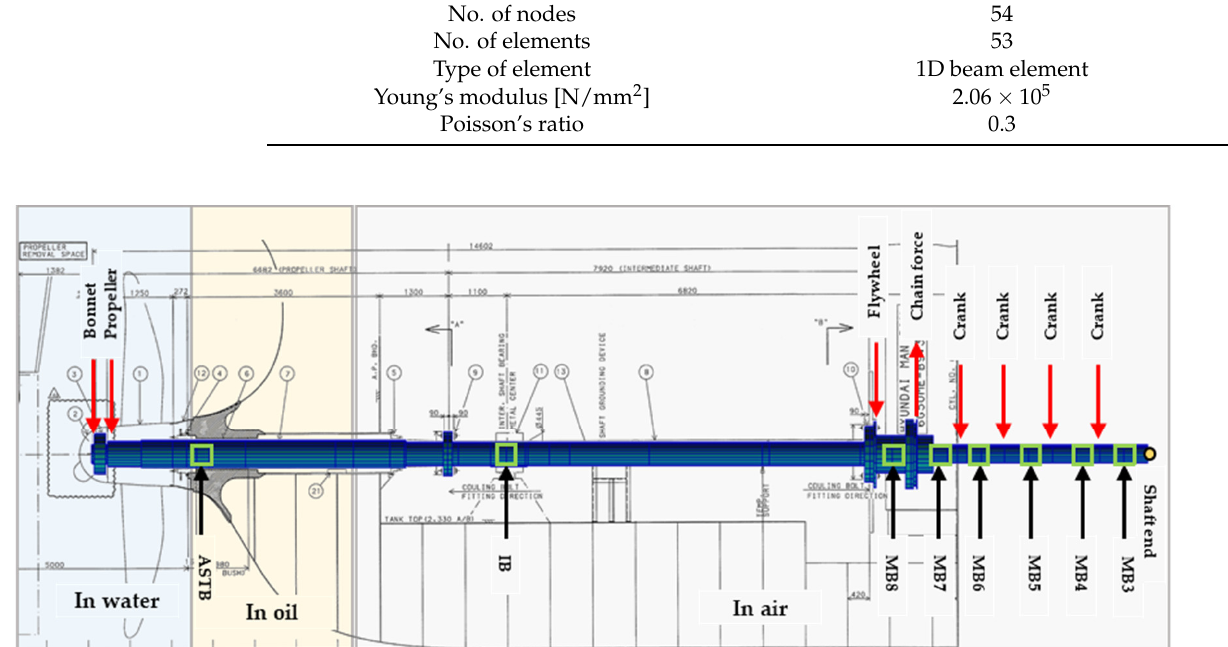
Figure 12. Shaft FE model. Table 8. Shaft FE model details.